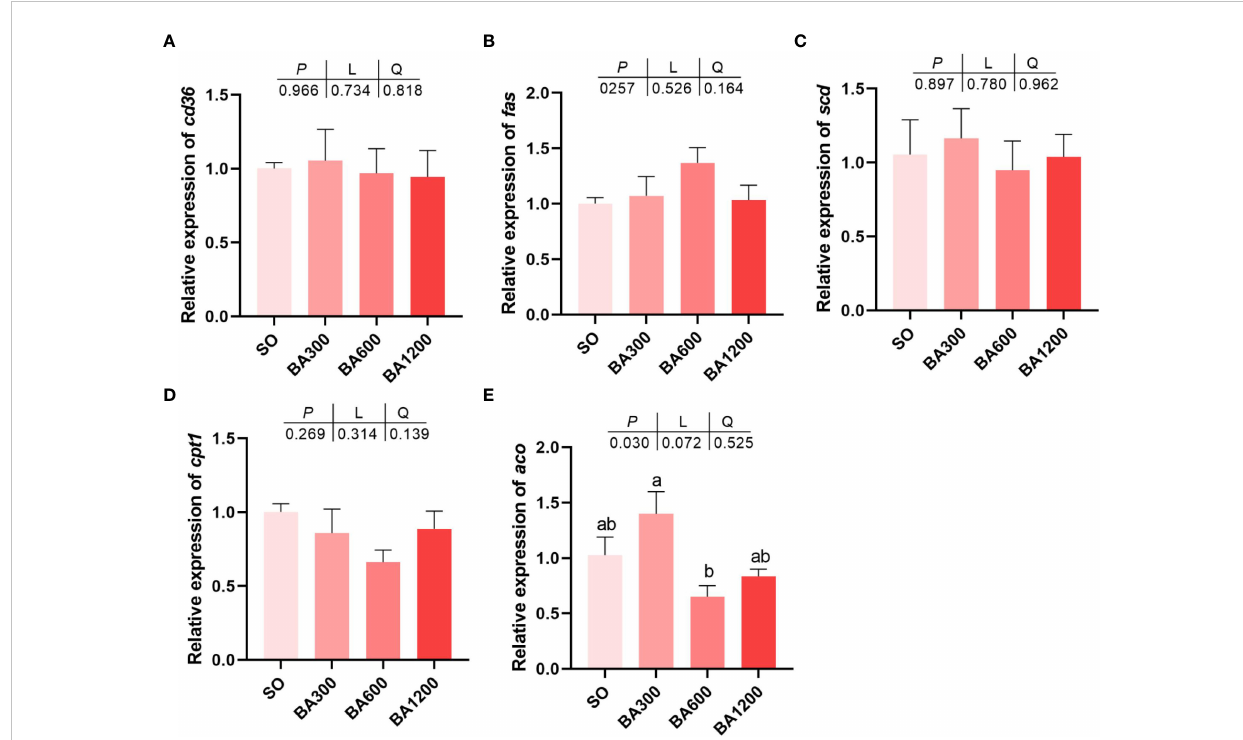
FIGURE 3 Gene expression of lipid metabolism (A-E) in the muscle of juvenile large yellow croaker in different treatments. Values are represented as mean ± SEM (n = 3). Bars with different lowercase letters represent signi fi cant difference ( P < 0.05). cd36 , cluster of differentiation 36; fas , fatty acid synthase; scd , stearoyl-coenzyme A desaturase; cpt1 , carnitine palmitoyl transferase 1; aco , acyl-CoA